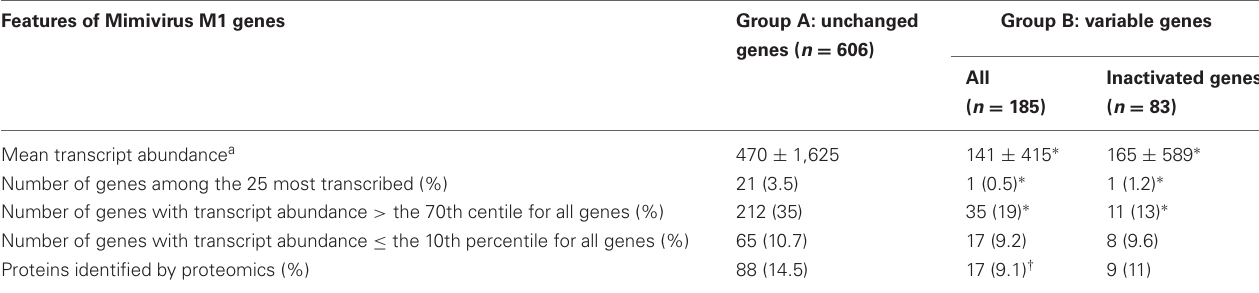
Table 1 | Comparative features for unchanged, variable, and inactivated Mimivirus genes after 150 passages in allopatric culture on